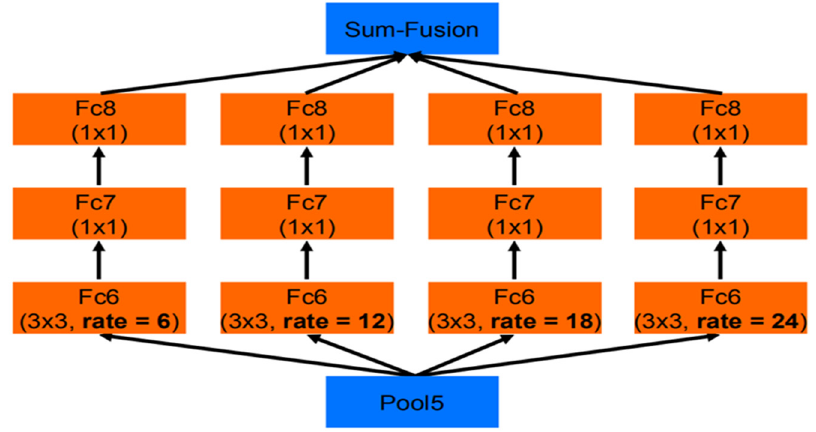
Figure 5. Schematic diagram of ASPP.